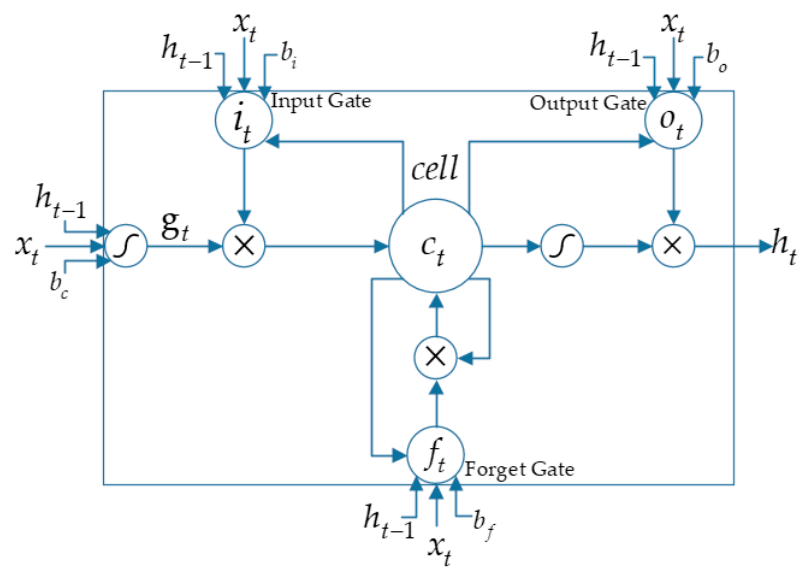
Figure 2. Basic structure of long short-term memory (LSTM).